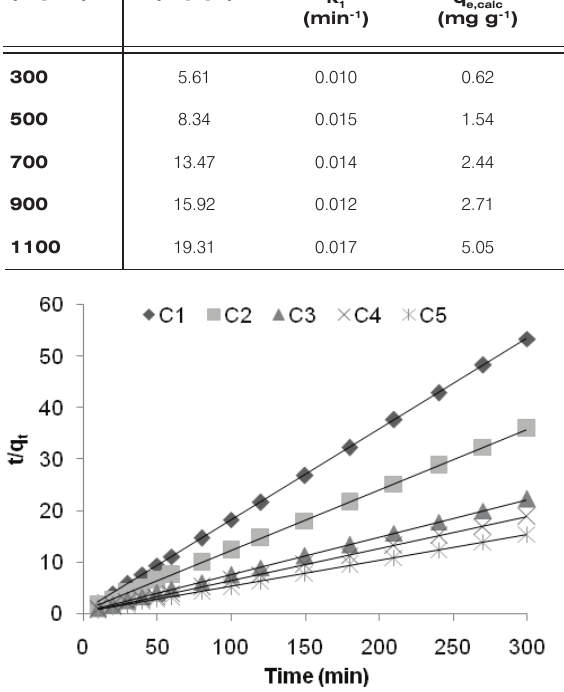
Table 3. Pseudo-first-order and pseudo-second-order reaction kinetics constants and ionic exchange values for zinc sorption on Amberlite IRA410. q C 0 e,exp (mg L -1 ) (mg g -1 )